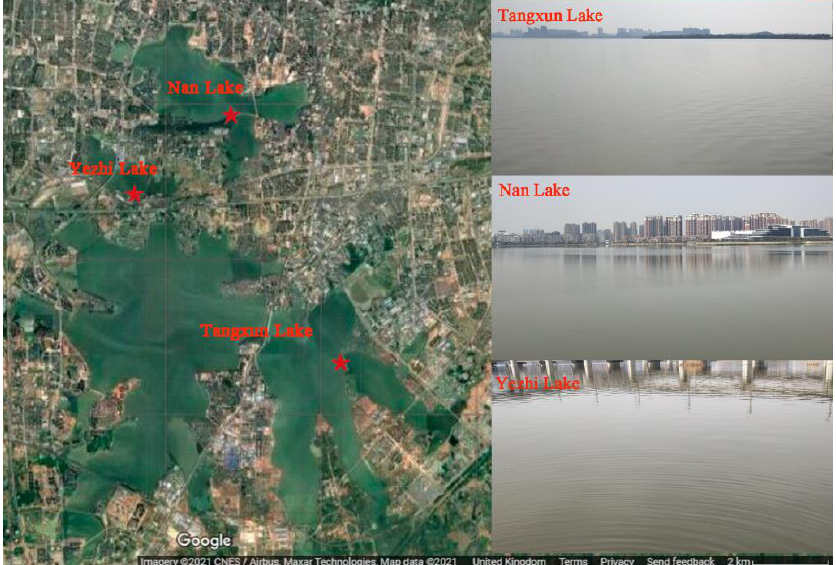
Figure 1. A map with the location of the three lakes and sampling sites.